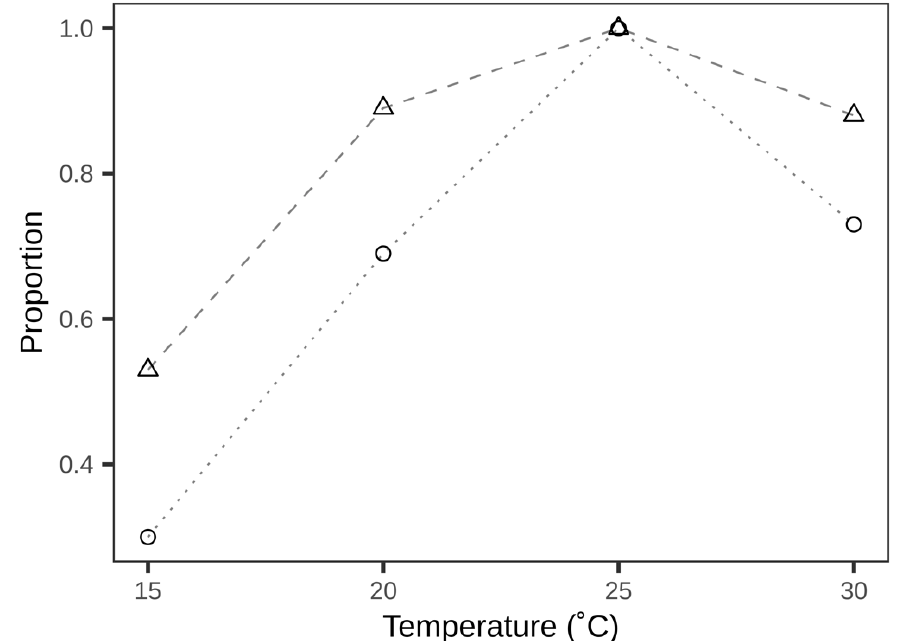
Figure 2. Comparison of relative laboratory fecundity (triangles and dashed line) from [24] and relative parasitisation efficiency (proportion of parasitised eggs) (circles and dotted lines) from this study. Relative values for each parameter were calculated by dividing absolute values at each temperature by the maximum (which occurred at 25 °C in both parameters).